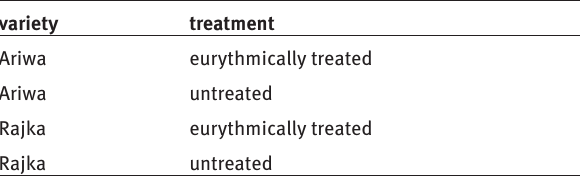
Table 1: Combinations of apple variety and eurythmic treatment variety